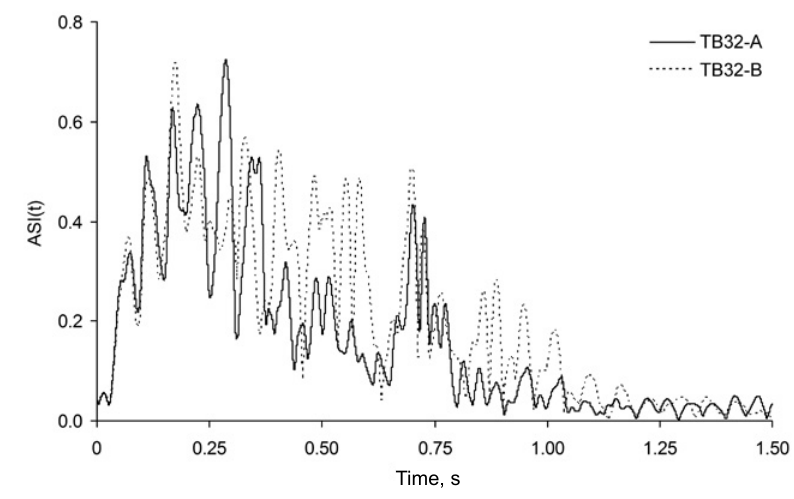
Figure 13. Comparison of energy balance for TB32-A (solid line) and TB32-B (dotted line)